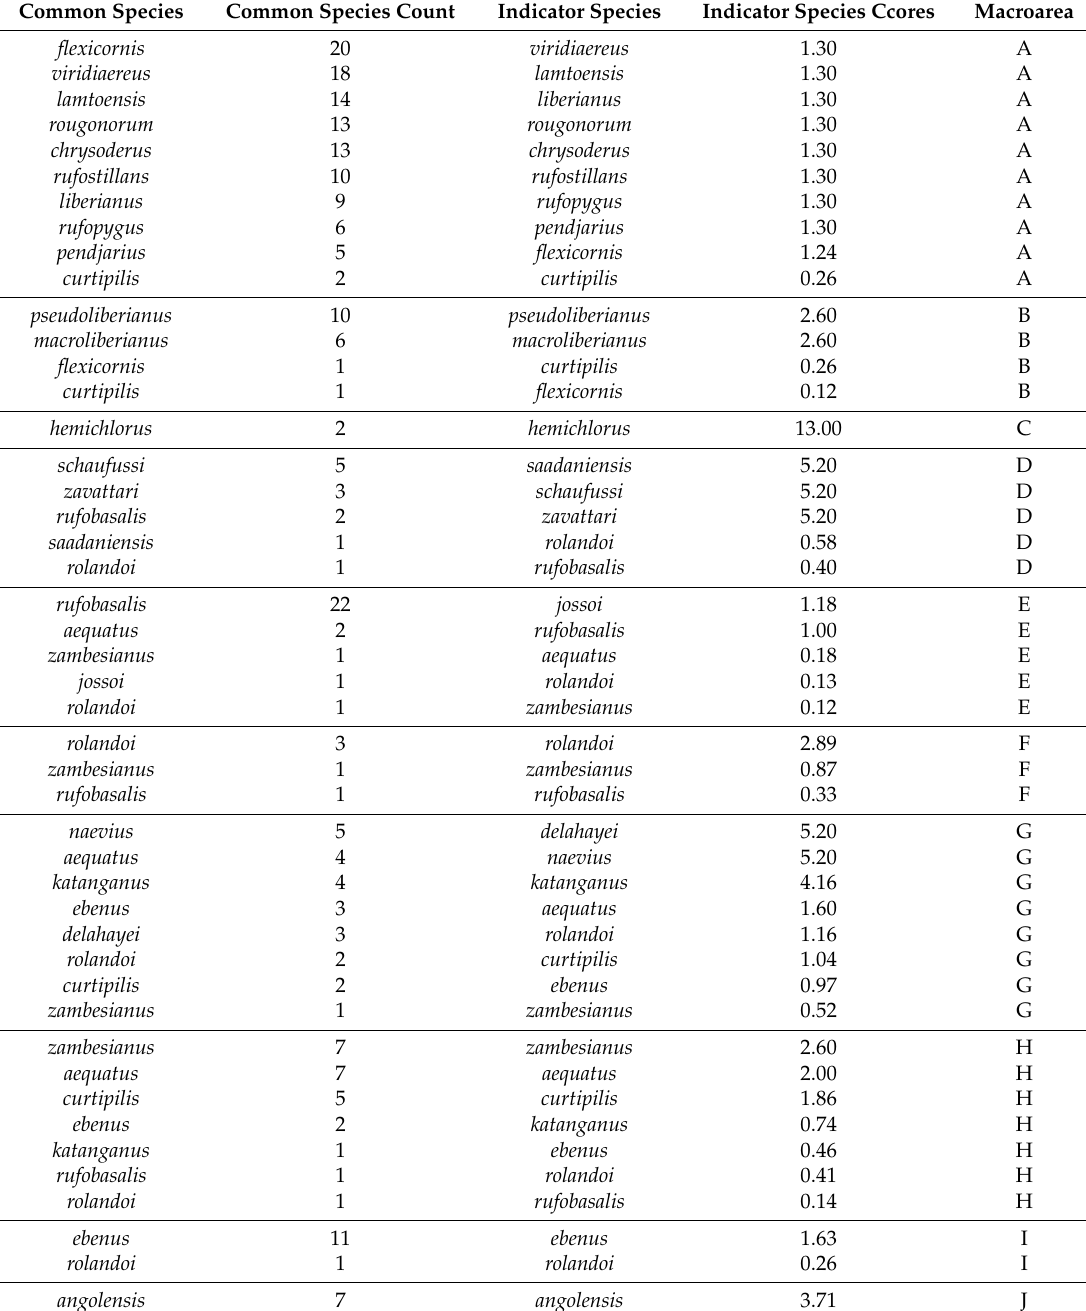
Table 2. Results of the InfoMap analysis, showing for each macroarea (A–J) the classification defined the common and indicator species. The lists of the species are arranged in decreasing